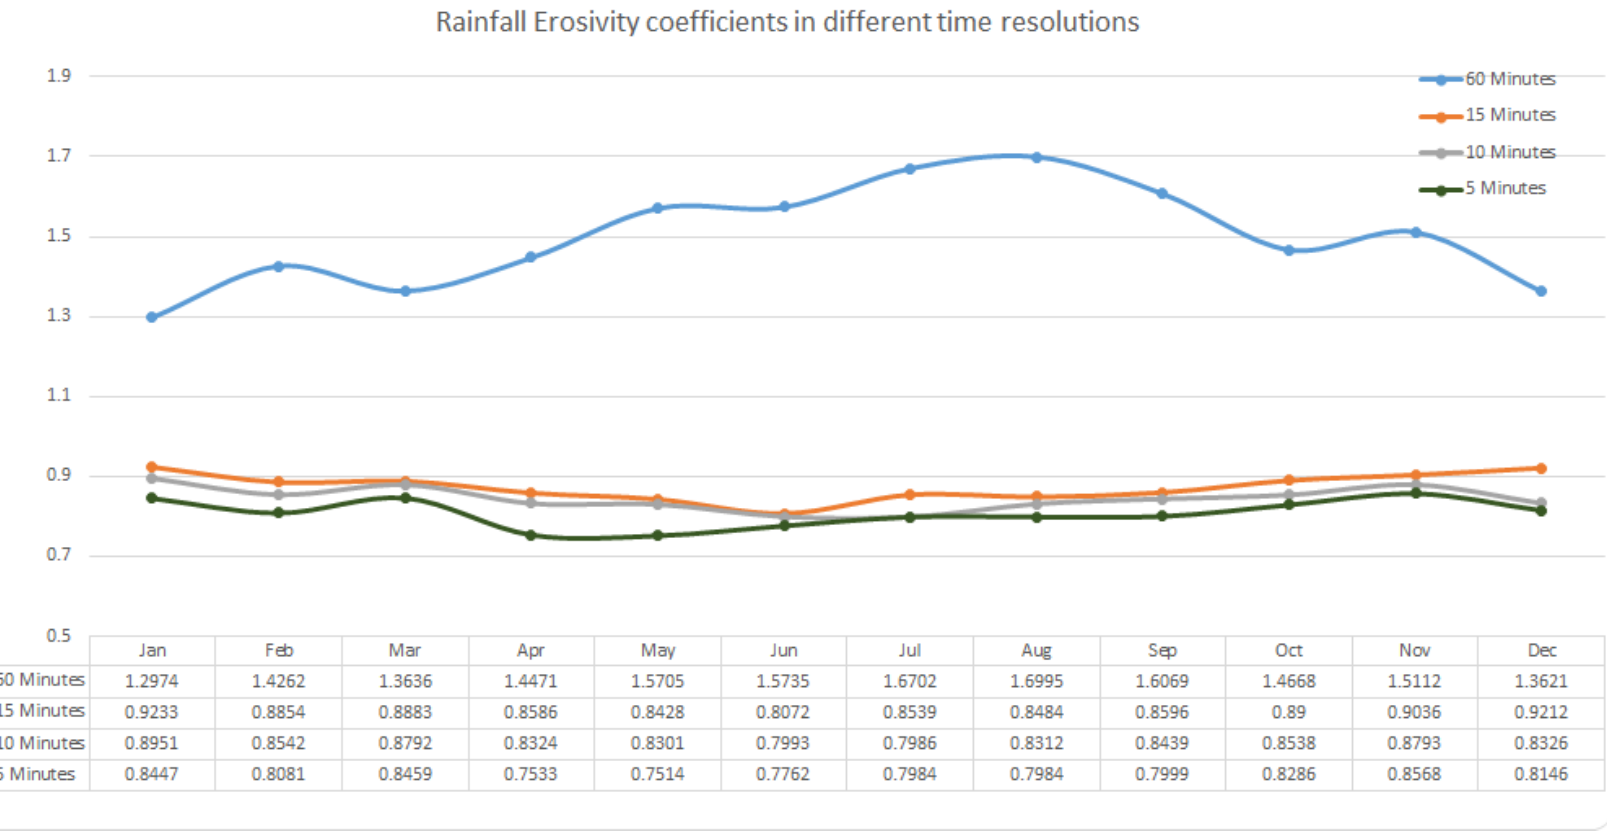
Figure 3. Monthly rainfall erosivity calibration factors for different resolutions (5-min, 10-min, 15-min, 60-min) compared to the R-factor base resolution of 30-min.